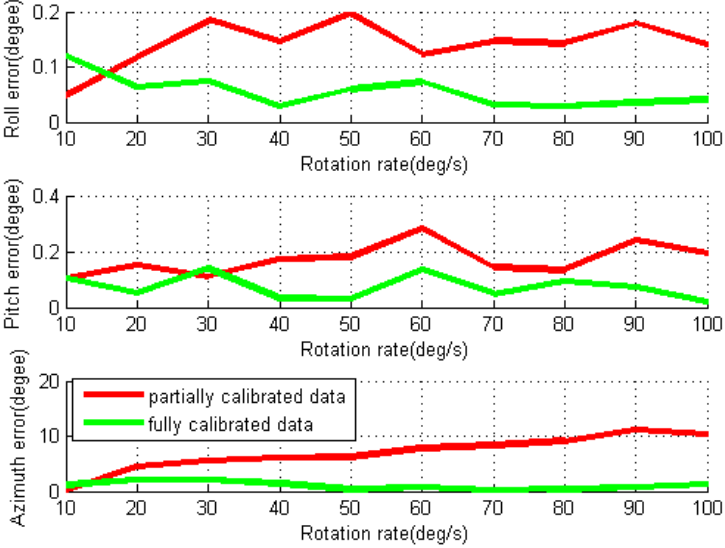
Figure 12. RMS values of attitude errors for rotary INS with different IMU rotation rates using NAV440.